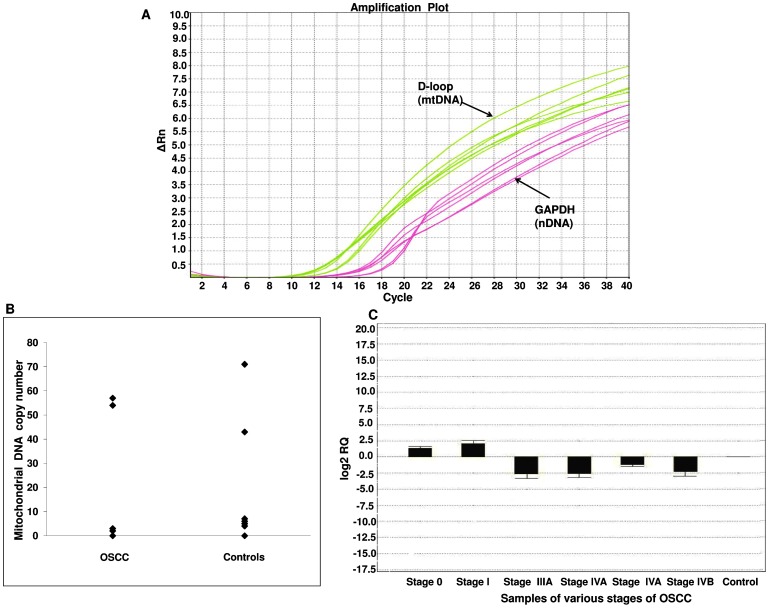
Real time PCR based mitochondrial DNA copy number determination in oral cancer.(A) Quantitative PCR of D-loop region and GAPDH gene (representative curve). D-loop region and GAPDH are ubiquitous genes found in the mitochondrial and nuclear genomes, respectively. Using quantitative PCR in samples from the patient and control, the relative mitochondrial content was calculated. (B) Distribution of mtDNA copy number in OSCC and controls. (C) Mitochondrial content decreases with increase in tumour stage: the various stages of OSCC samples from stage 0 to stage IVB with respect to log 2 RQ (log fold change).